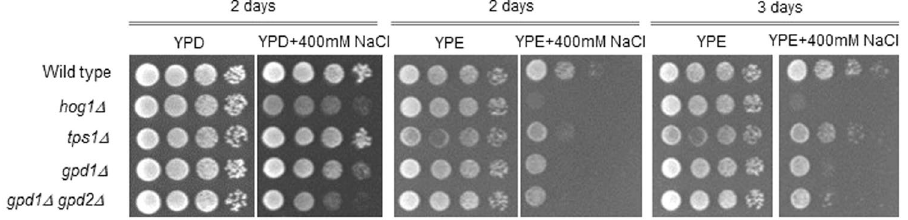
Figure 3. Growth phenotypes of wild and mutant BY4147 cells on complete YPD and YPE with and without 400 mM NaCl. Cells were pregrown in YPD or YPE, cell titres were adjusted and then 1:10 dilution series were spotted on agar plates. Growth was recorded after 2 and 3 days at 30 °C as indicated.